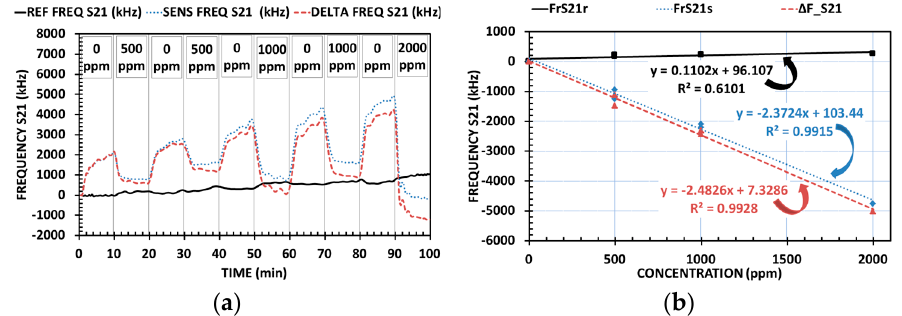
Figure 4. ( a ) Real-time frequency variation with different ethanol vapor concentrations; ( b ) Resulting experimental steady state frequency shift (monitored at 10 min) and